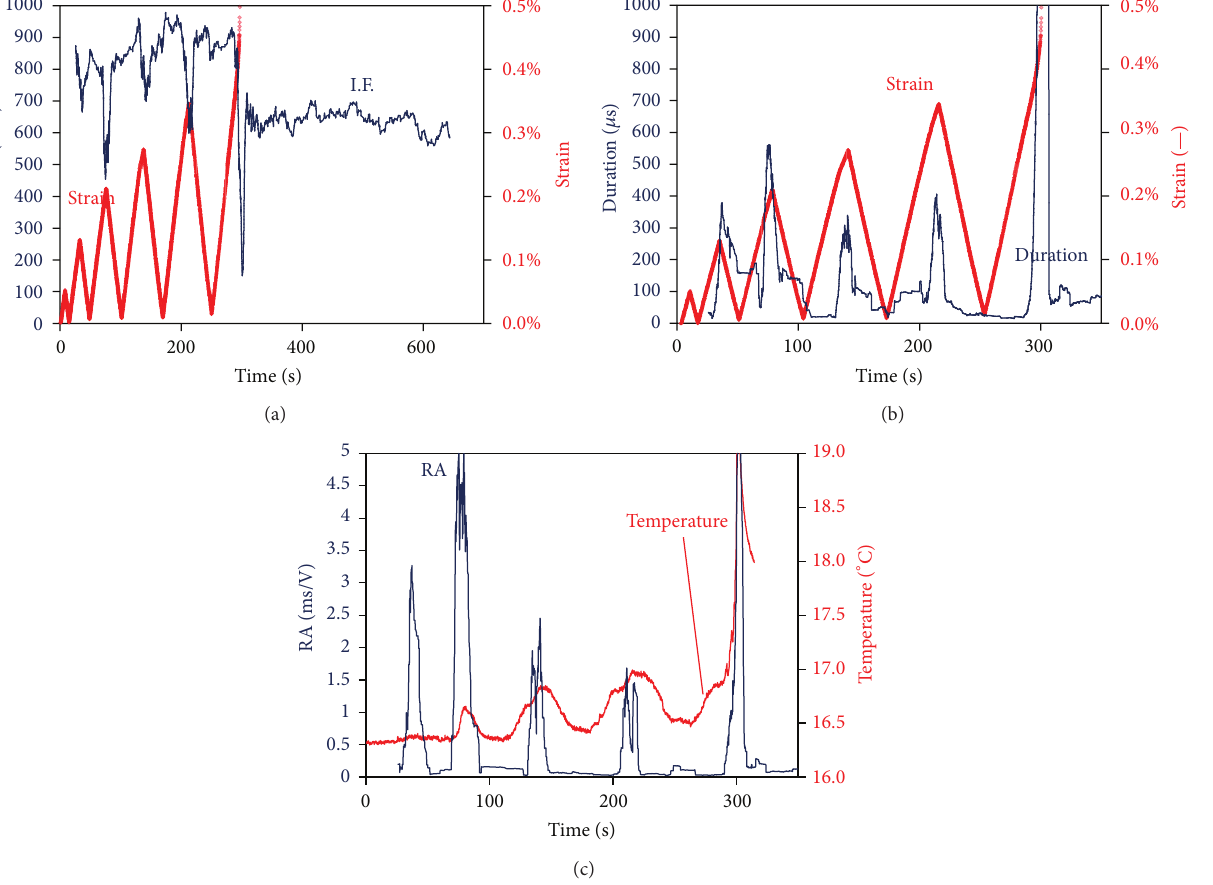
Figure 9: Initiation frequency and strain versus time (a), duration and strain versus time (b), and RA and temperature versus time (c) for specimen B (notch-to-width